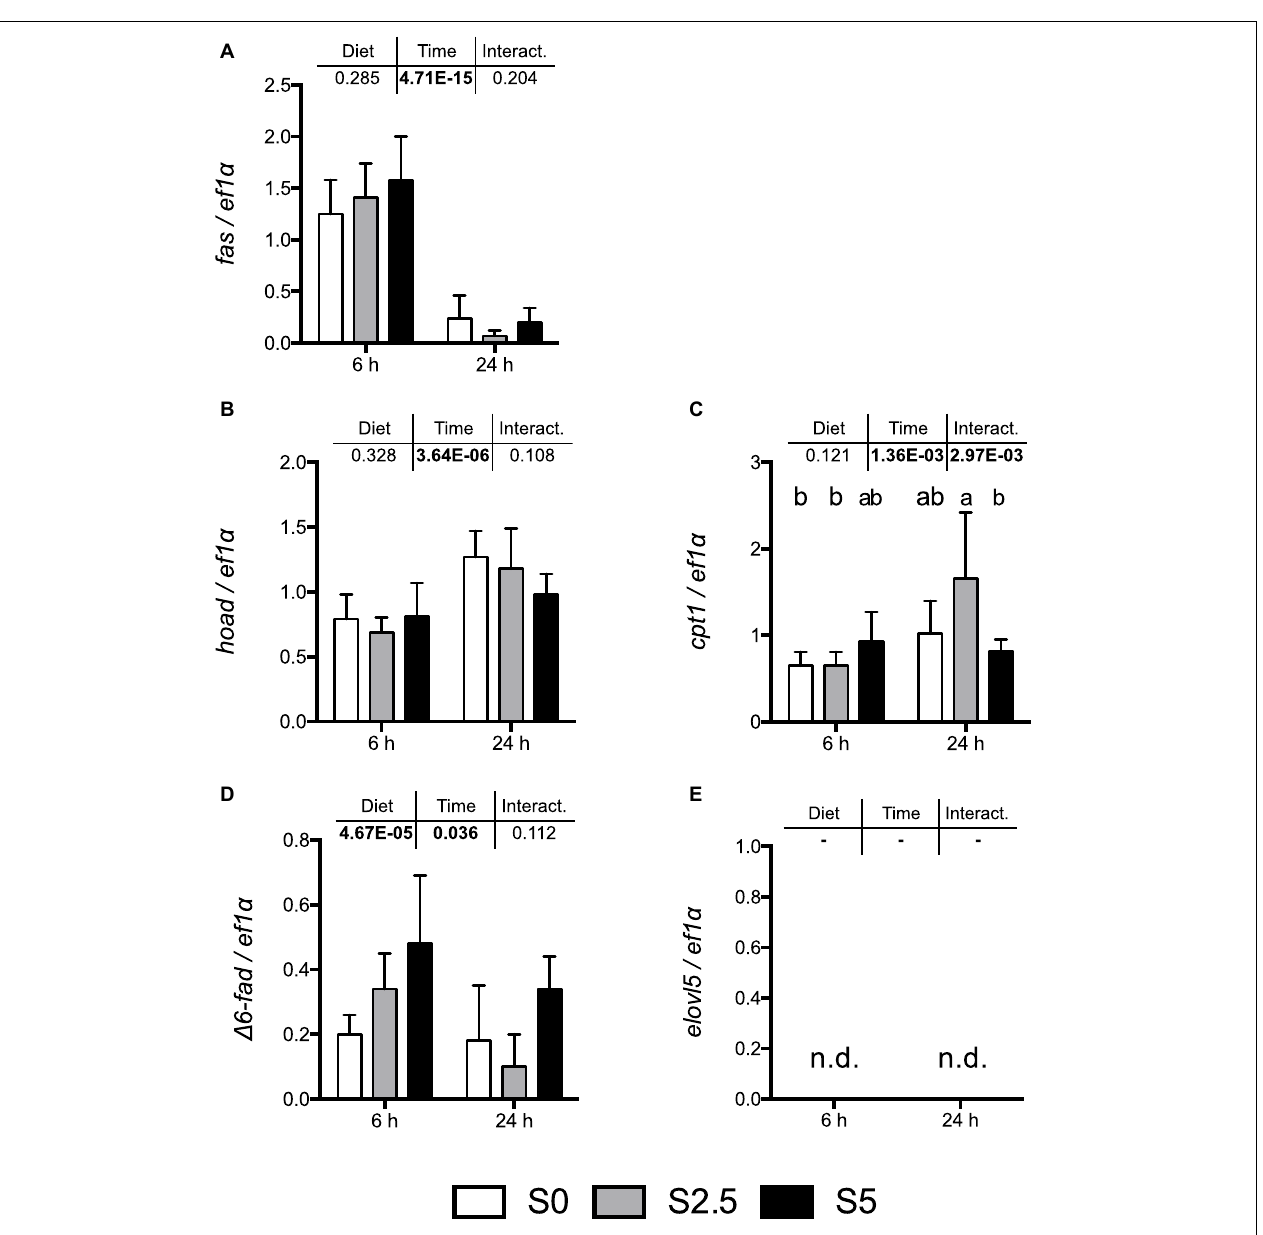
FIGURE 3 | mRNA levels of selected lipogenic enzymes (A) fas (fatty acid synthase); lipolytic enzymes (B) hoad (3-hydroxyacyl-CoA dehydrogenase) and (C) cpt1 (carnitine palmitoyltransferase I); and enzymes involved in long chain PUFA biosynthesis: (D) (cid:49) 6-fad (acyl-CoA 6-desaturase) and (E) elovl5 (elongation of very long-chain fatty acid protein 5) in the liver of European seabass ( Dicentrarchus labrax ) fed with different levels of glycerol (0, 2.5, and 5%) for 8 weeks. Values are mean ± SD ( n = 7); n.d.: not detected. Significant differences were evaluated by two-way ANOVA ( p < 0.05, values in bold). In the case of significant interactions, significant differences are indicated by different letters (one-way ANOVA, p < 0.05; followed by Tukey’s